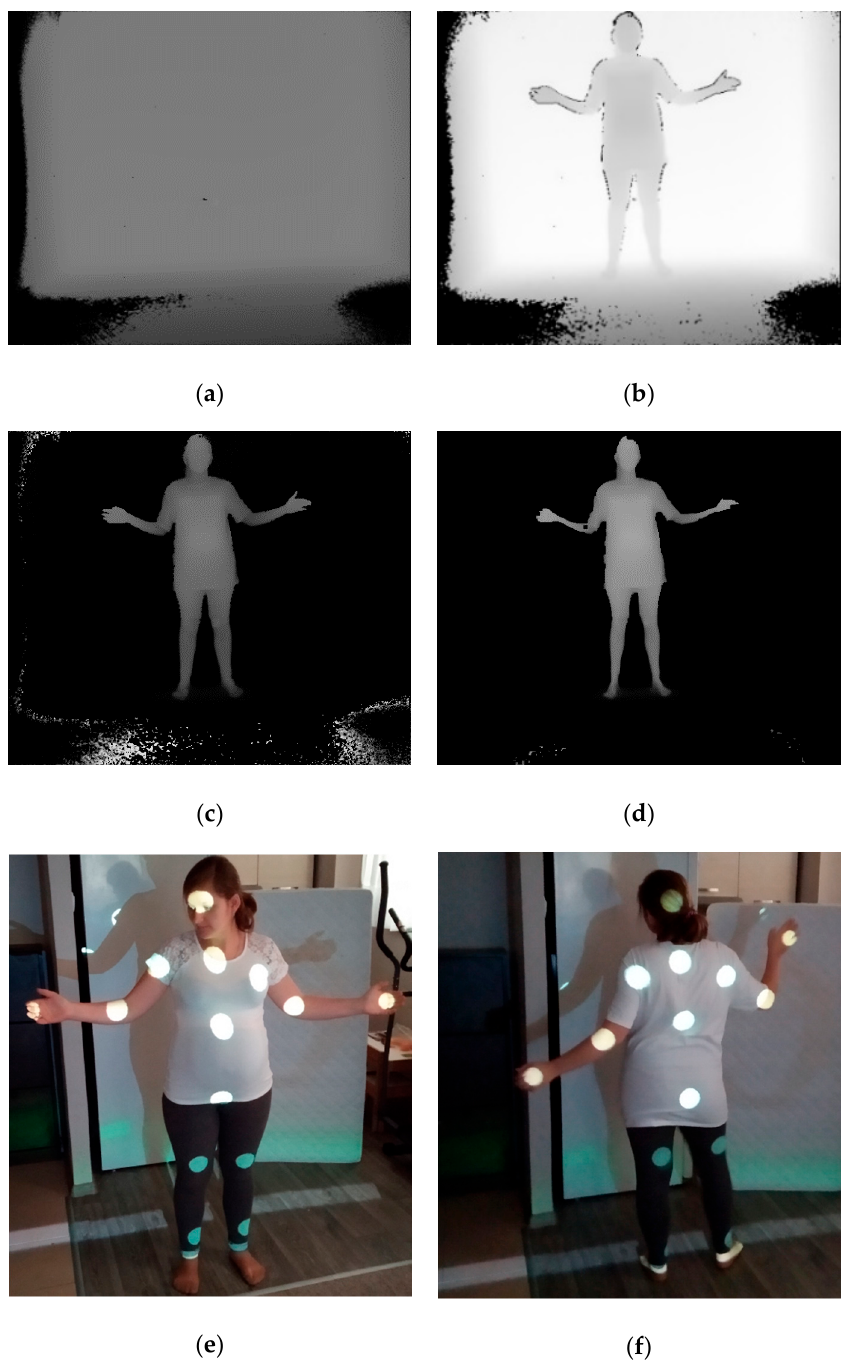
Figure 8. Background extraction process: ( a ) background, ( b ) current frame with a visible moving object, ( c ) result of background extraction, ( d ) image after noise elimination, ( e ) human silhouette front view with light spots on joints, ( f ) human silhouette back view with light spots on joints.